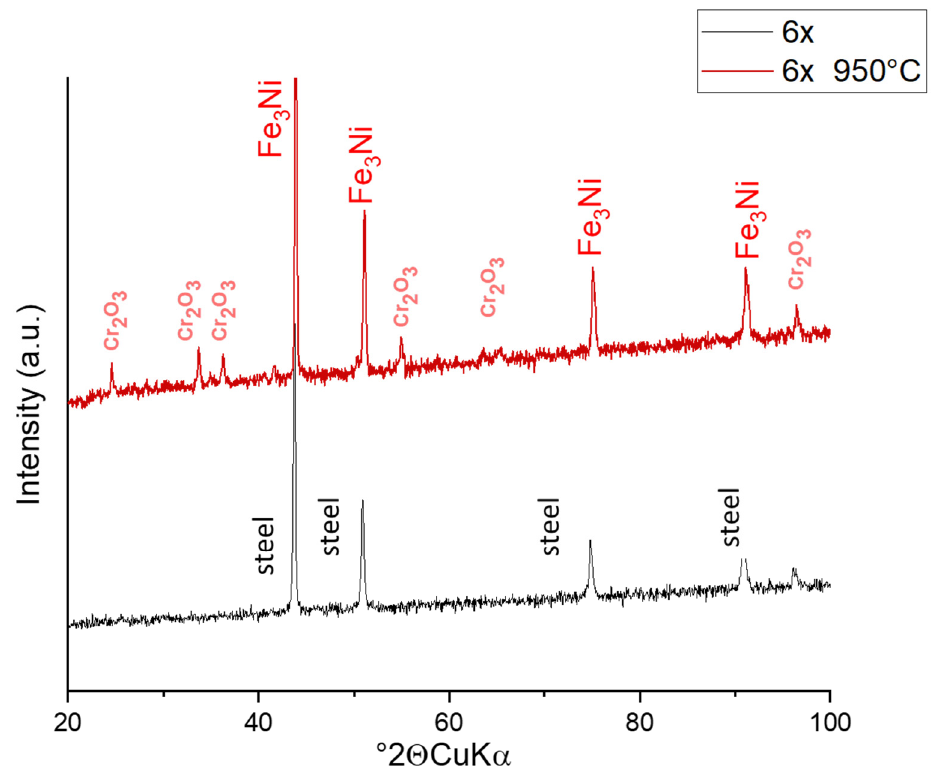
Figure 8. XRD pattern of sample 6× used before and after treatment. The most intensive peaks are noted with analyzed phase name .